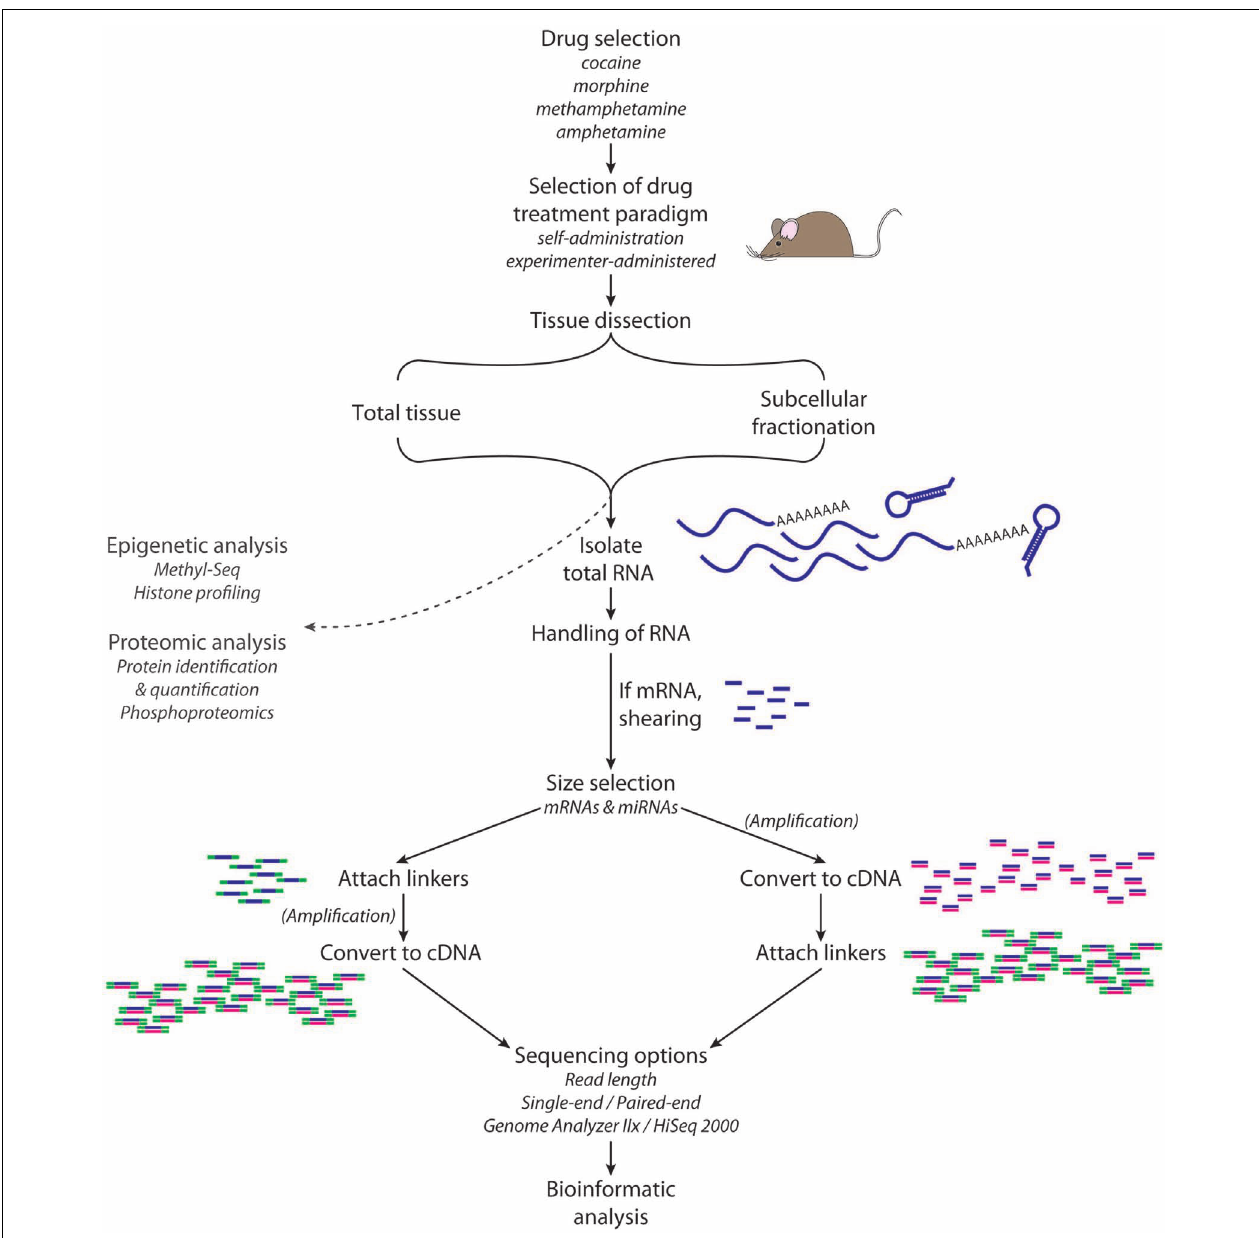
linker is attached to the 5 (cid:48) -end of each RNA fragment; a different linker is then attached to the 3 (cid:48) -end. Reverse transcription followed by PCR yields sufficient material for analysis. Adaptor sequences are computationally removed from the sequencing data, and then sequences are aligned with annotated